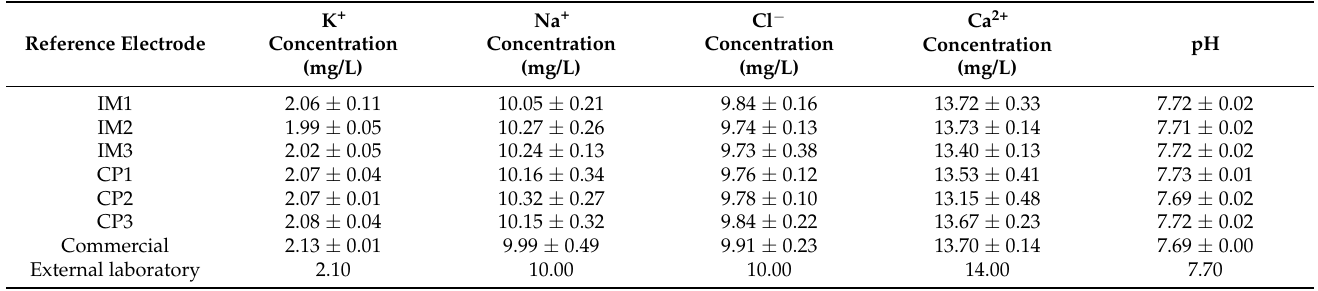
Table 4. Ion concentrations measured in RW2 at room temperature (22 ± 1 ◦ C) using SSC and commercial reference electrodes and compared with the results from routine laboratory analyses.